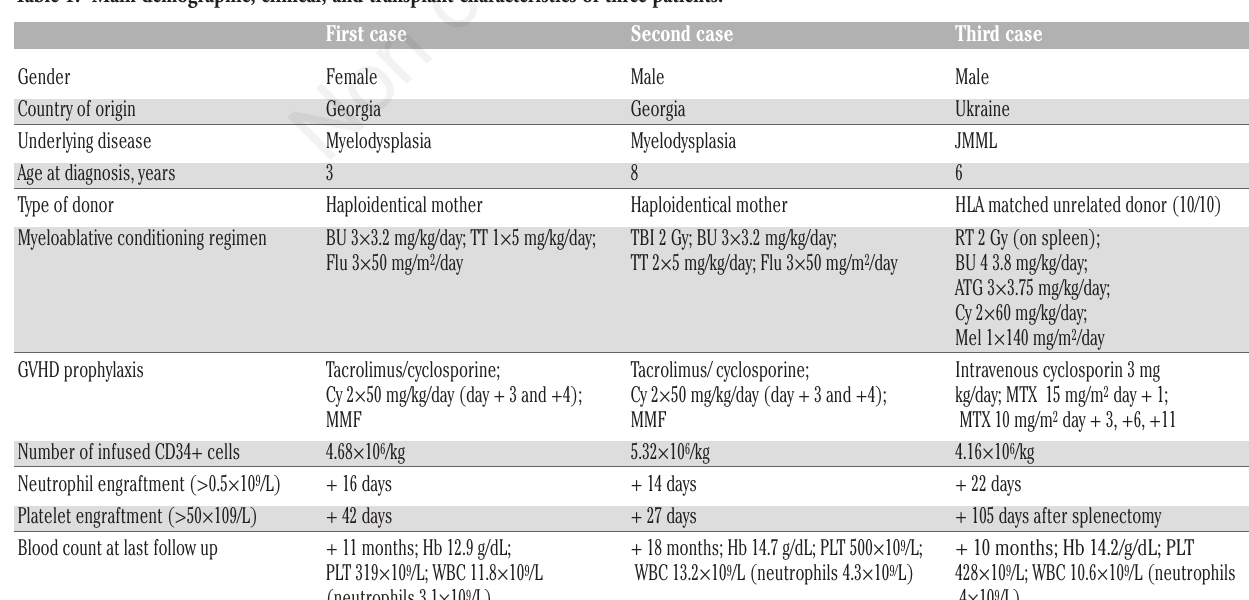
Table 1. Main demographic, clinical, and transplant characteristics of three